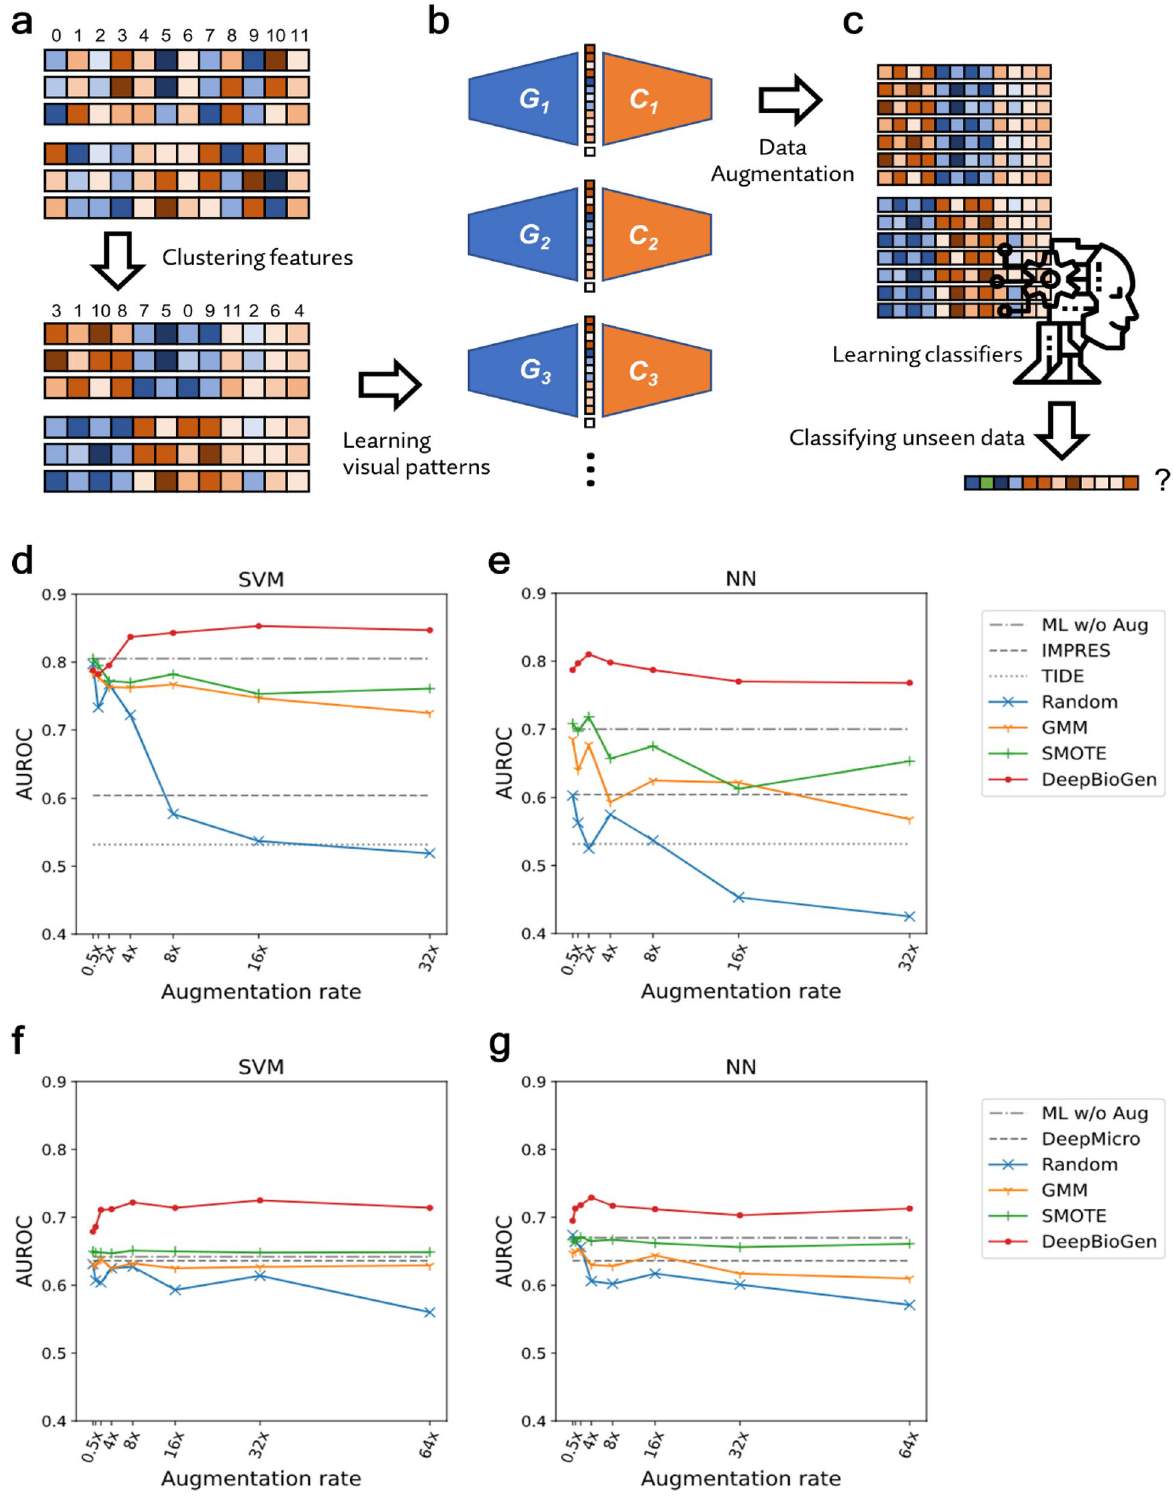
Figure 1. DeepBioGen, a sequencing profile augmentation procedure that generalizes classifiers to enhance prediction performance on unseen data. ( a ) Feature-wise clustering of sequencing profiles to form perceptible visual patterns. ( b ) Training multiple conditional Wasserstein GANs equipped with up-convolutional and convolutional layers. ( c ) Generating augmented data from the multiple generators of GAN models and learning classifiers based on the augmented data along with source data to predict unseen data. ( d , e ) Results of anti-PD1 therapy response prediction on unseen data by the state-or-the-art and baseline classifiers (gray) and by classifiers generalized with DeepBioGen (red), SMOTE (green), GMM (yellow), and Random augmentation (blue); Classification algorithms: Support Vector Machine (SVM) and Neural network (NN) which is a multi-layer perceptron; Evaluation metric: Area under the receiver operating characteristics (AUROC). ( f , g ) Results of type 2 diabetes prediction on unseen